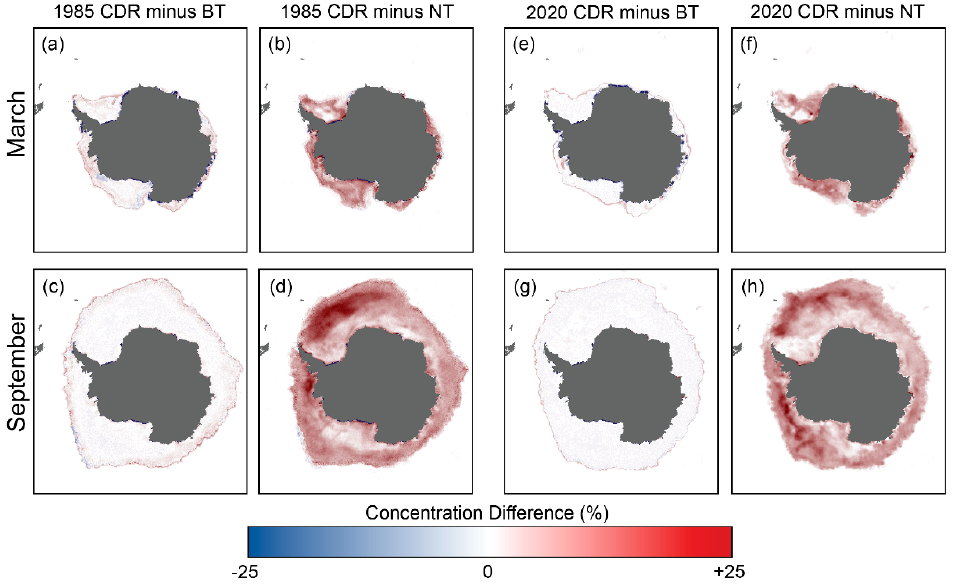
Figure 2. Southern Hemisphere sea ice concentration difference between CDR and the BT and NT algorithm products for March and September for two example years, 1985 ( a – d ) and 2020 ( e – h ).